Question: Summarize what this figure shows in one sentence.
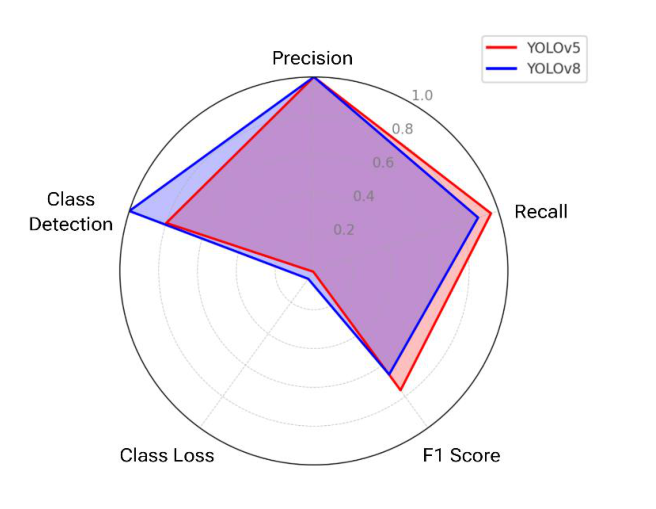
Answer: Radar chart comparing performance of YOLOv5 and  YOLOv8